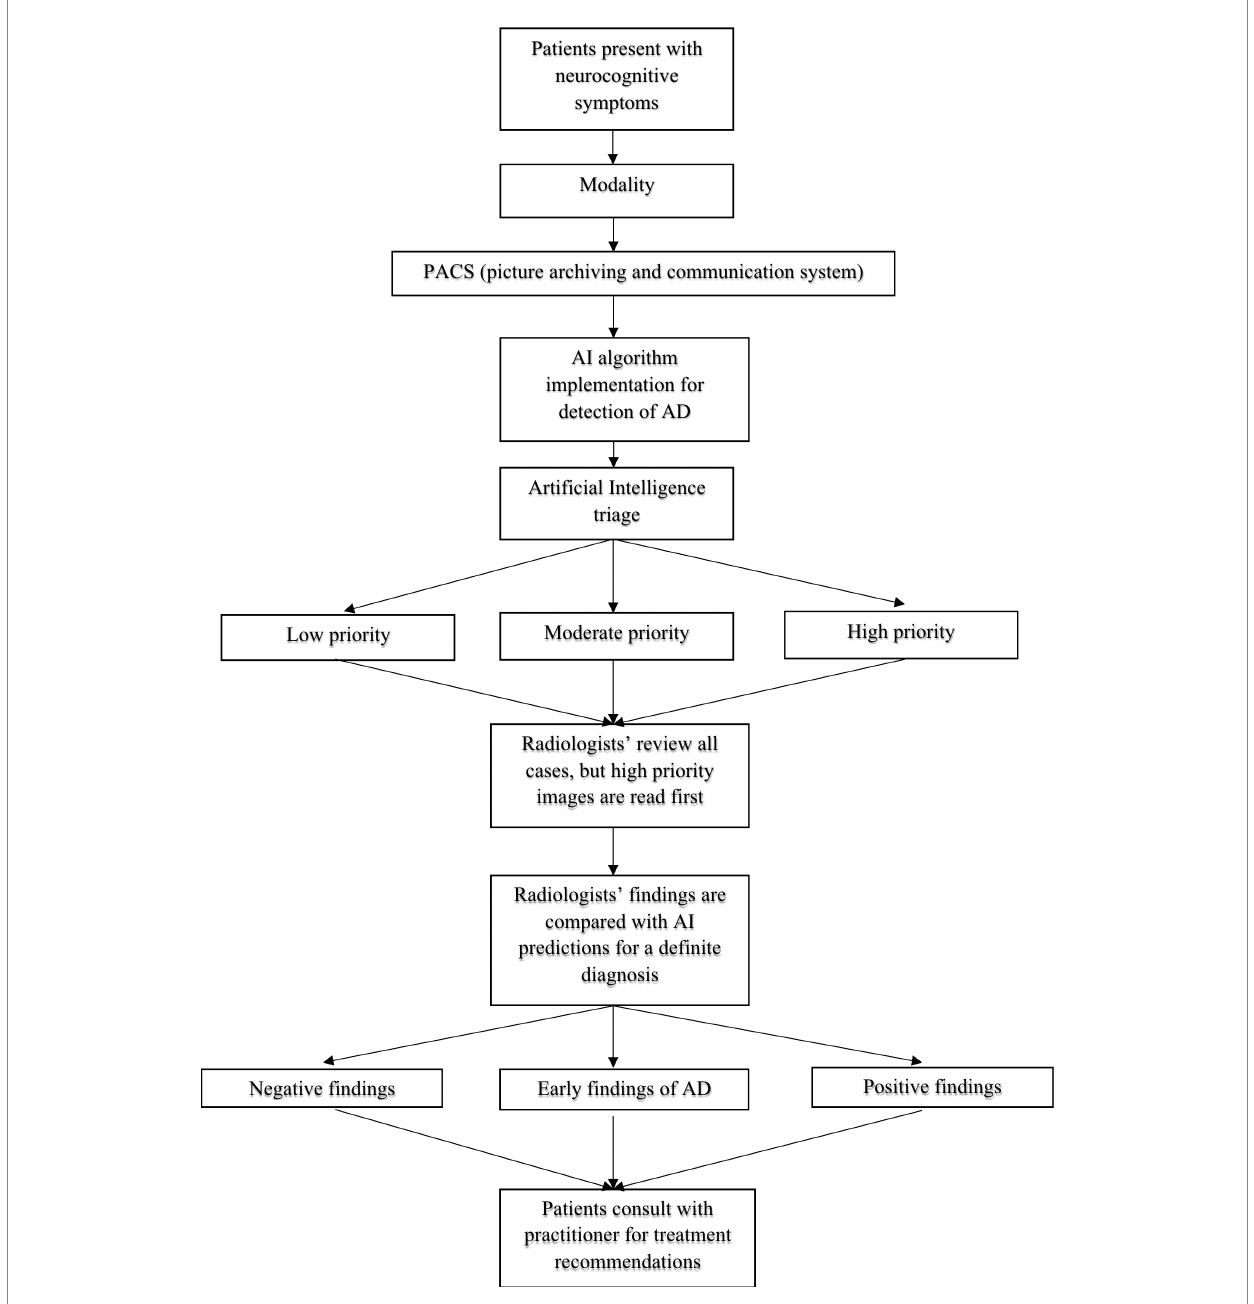
FIGURE 1 Legend: Patients present with neurocognitive symptoms ranging from noticeable memory loss, trouble performing routine tasks, confusion, personality changes, etc. A brain scan is performed in the clinic using the appropriate modality such as CT, MRI, or PET. The image is stored into the picture archiving and communication systems (PACS) database and processed into an artificial intelligence-based system to detect and sort low, moderate, and high priority brain scans. High priority cases are reviewed first by the radiologists followed by moderate and low cases. Once a diagnosis is made, the findings are compared with the AI database. If the radiologist’s decision does not match with the AI system, a second opinion is needed before making a definite diagnosis. Once a definite diagnosis is made, the patients can consult with their practitioner for future treatment